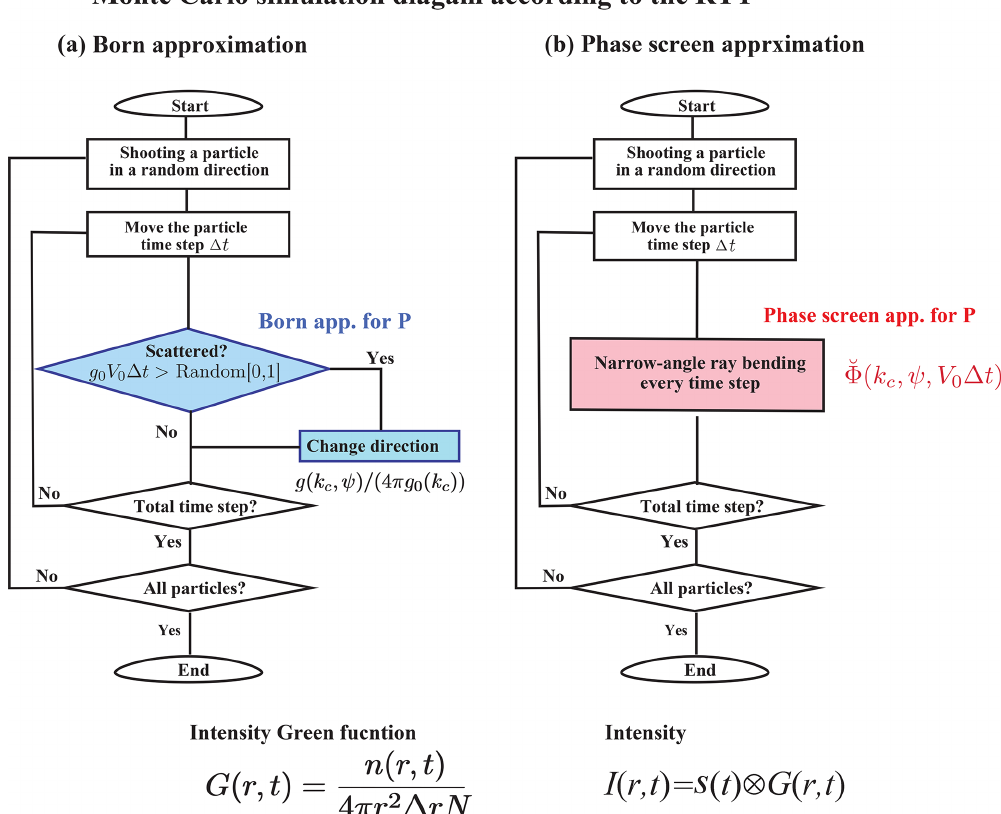
Figure 8. Flowchart of the Monte Carlo simulation code according to the RTT for the scalar wavelet intensity in uniform random media. (a) RTT with the Born approximation. (b) RTT with the phase screen approximation.